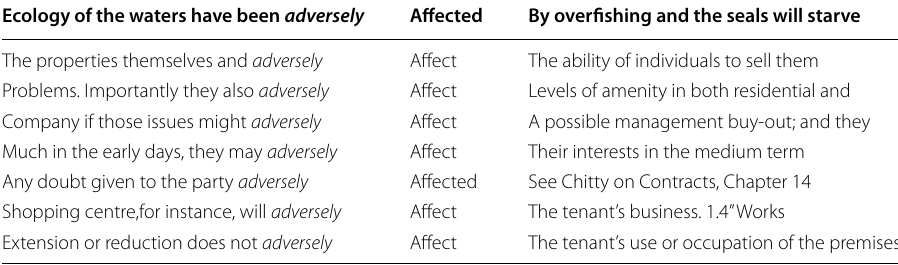
Table 4 Examples of concordance lines of adversely Ecology of the waters have been adversely Affected